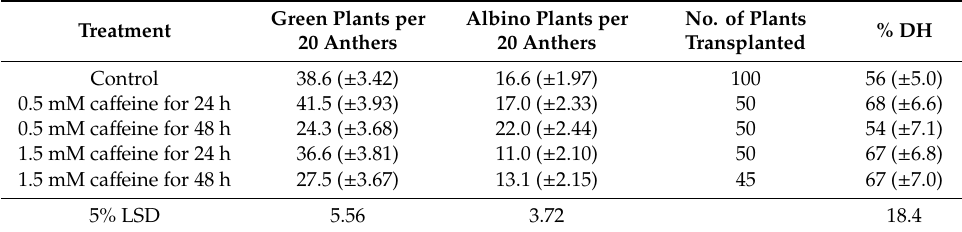
Table 1. Means ( ± standard error [SE]) of green and albino plant numbers, expressed per 20 anthers, and chromosome doubling (% doubled haploid (DH)) following ca ff eine treatment during anther culture on the (Yr57 / 3*Gladius#60) / 2*Trojan cross in 2017. LSD: least significant di ff erence.